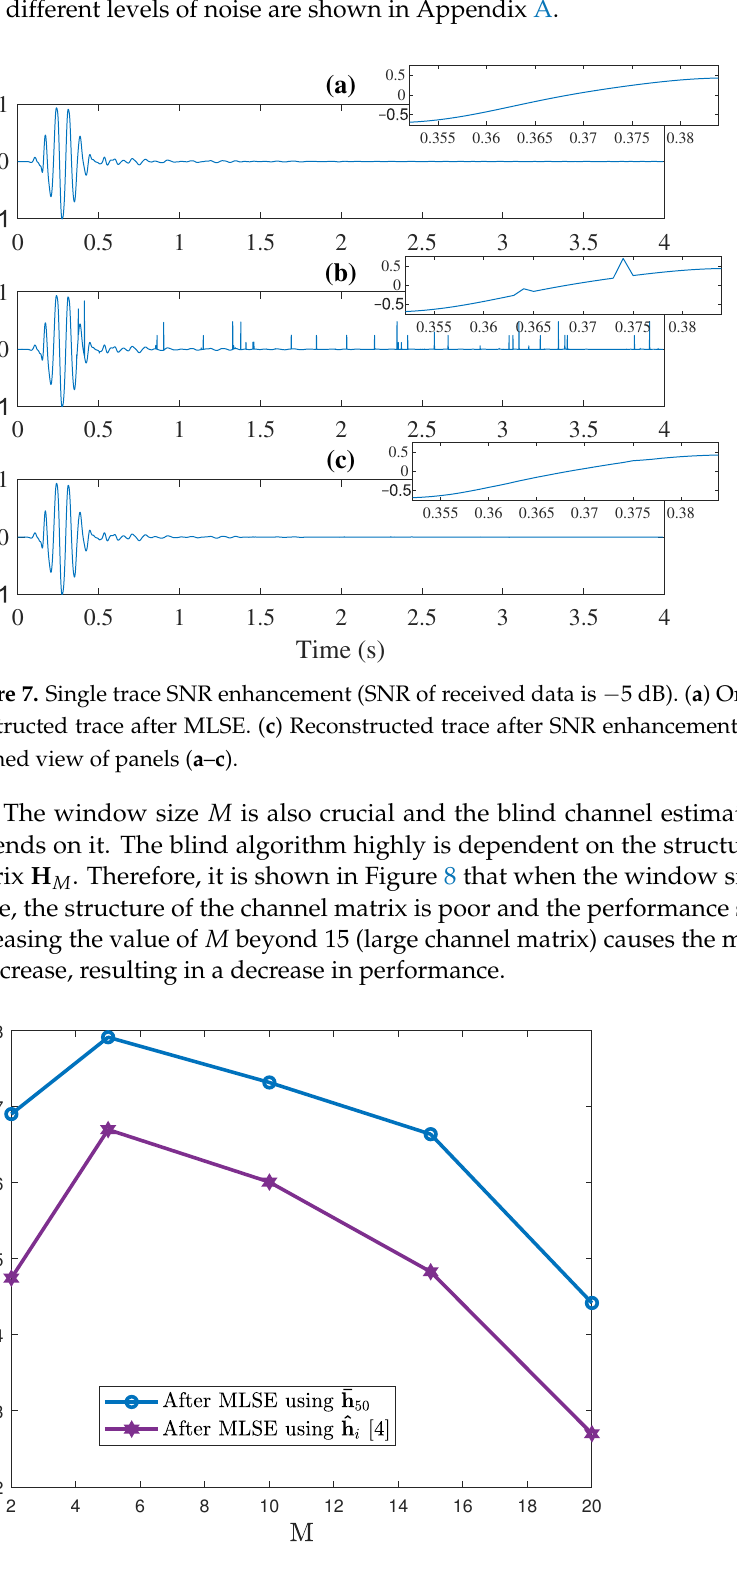
Figure 8. SNR enhancement versus various values of window size M (SNR of the received data is − 5